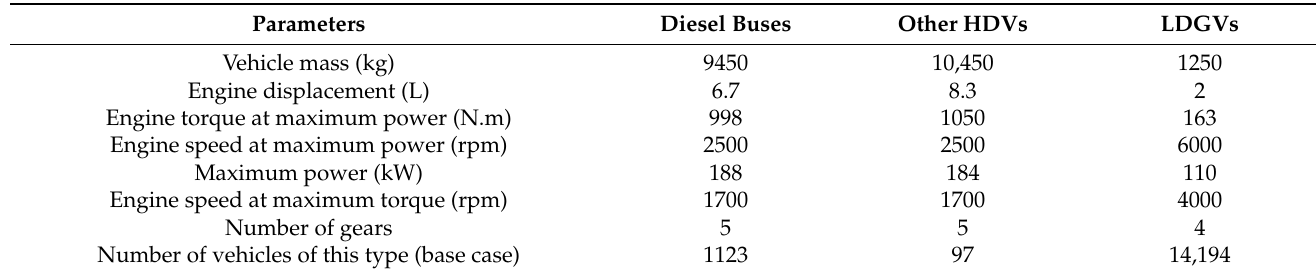
Table 5. Boundary condition of the physical model.